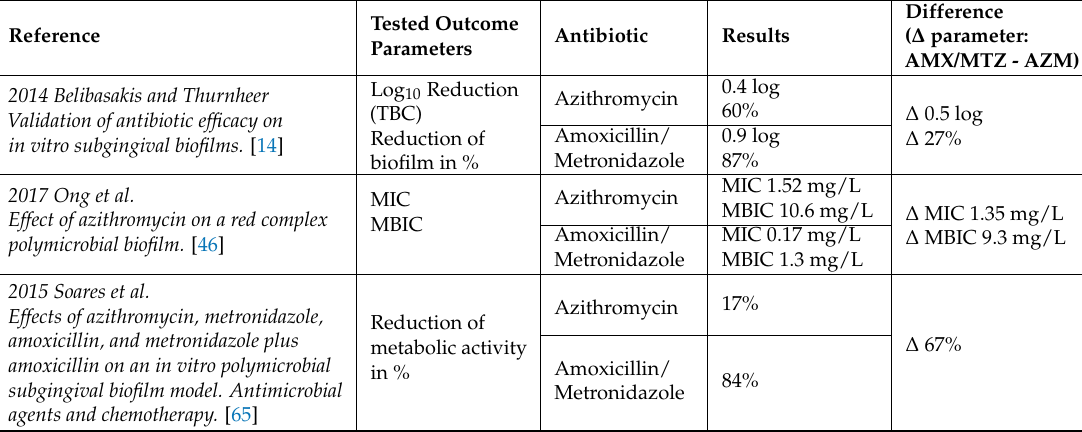
Table 2. Comparison of the three